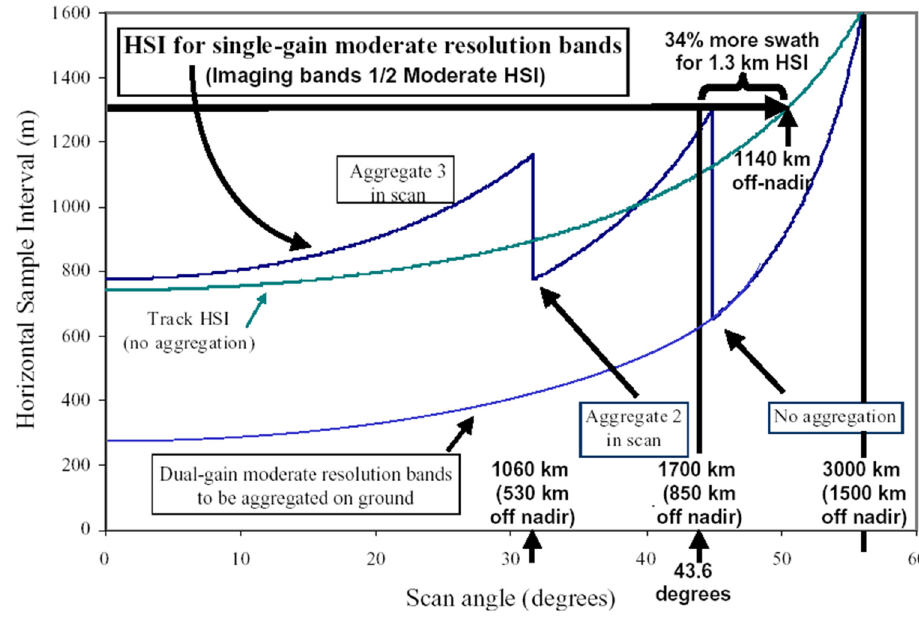
Figure 1. VIIRS horizontal sampling interval (HSI) for a VIIRS moderate band as a function of scan angle. The light blue and green lines show the unaggregated pixel growth along-scan for the scan and track directions, respectively. The dark blue line shows the pixel growth for the scan direction with the three aggregation zones.